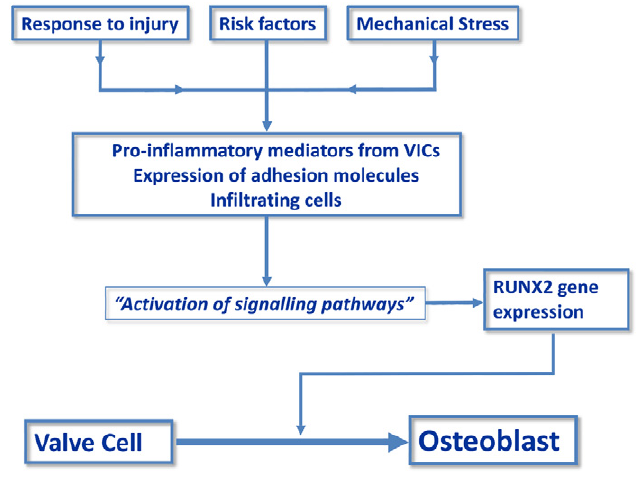
Figure.7 Flowdiagramshowingtheprogressionfrominitiationfactorstodifferentiationofvalveinterstitialcells into osteobalst-like